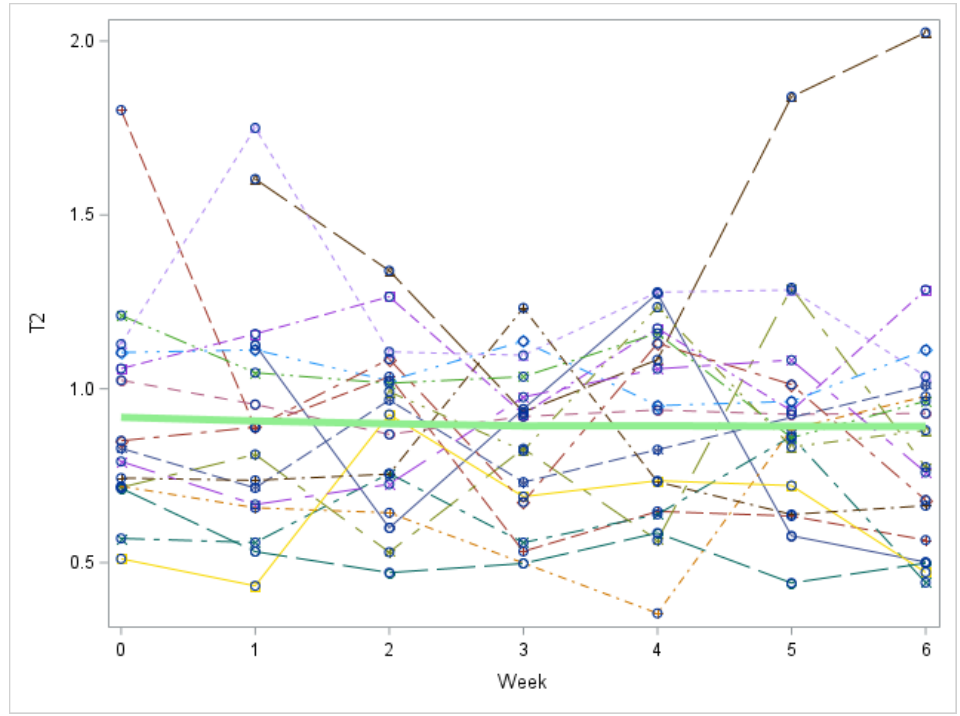
Figure A5. Study 2 by Week: 3-T1AM trend over time (Each individual line represents a patient. The green line represents the mean values for all patients). 3-T1AM = 3-T1AM concentration in nmol/L. There is no significant change in 3-T1AM over time, p =0.3633.